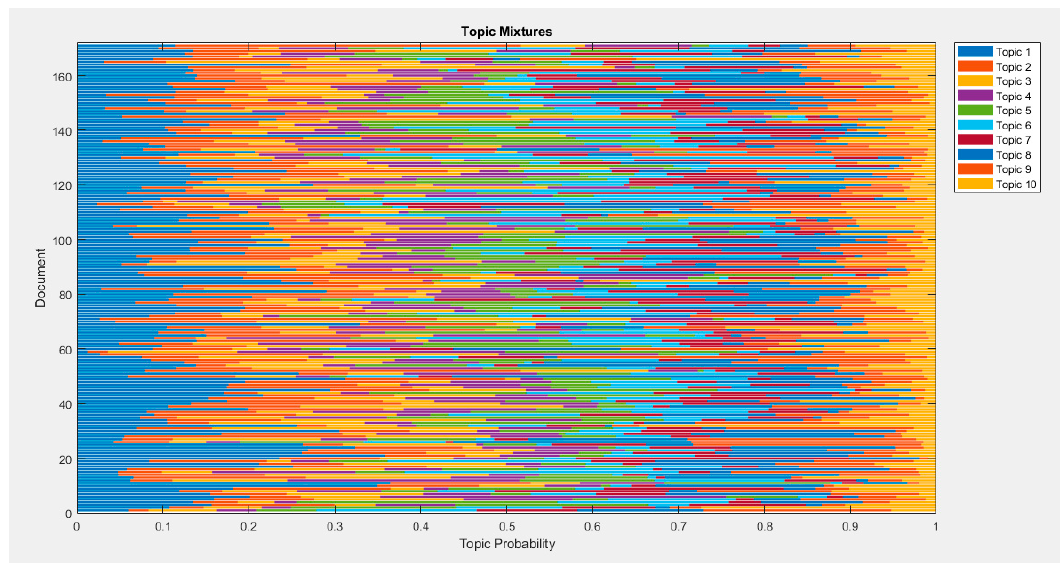
Figure 5. Topic mixtures generated through MATLAB.